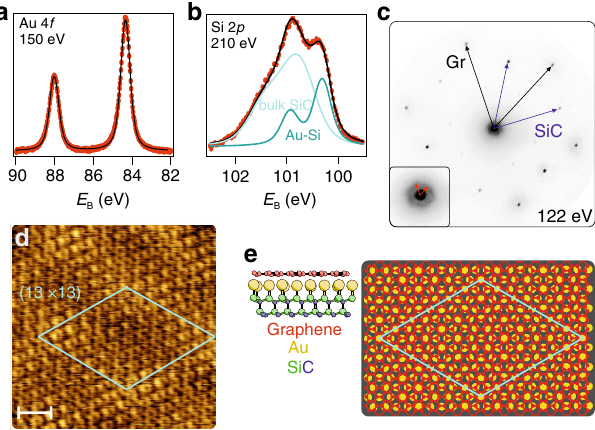
Fig. 2 Structural properties of the interface. Core level spectra acquired on a Au-intercalated monolayer of epitaxial graphene on SiC(0001) of a Au 4 f fi tted with a single Voigt doublet, b Si 2 p fi tted with two Voigt doublets. The photon energies are indicated in the panels. c μ LEED pattern recorded at 122 eV on Au-intercalated graphene. The inset highlights the (13 × 13) pattern observed around the (00) spot. d STM topography image over a (5.2 × 5.2) nm 2 region. The (13 × 13) moiré unit cell is indicated as a cyan diamond. Image recorded at U sample = 100 mV and I tunnel = 85 pA. Scale- bar 1 nm. e Ball-and-stick model of the gold atoms intercalated between graphene and SiC(0001). Side view and, on the right side, top view showing the (13 × 13)